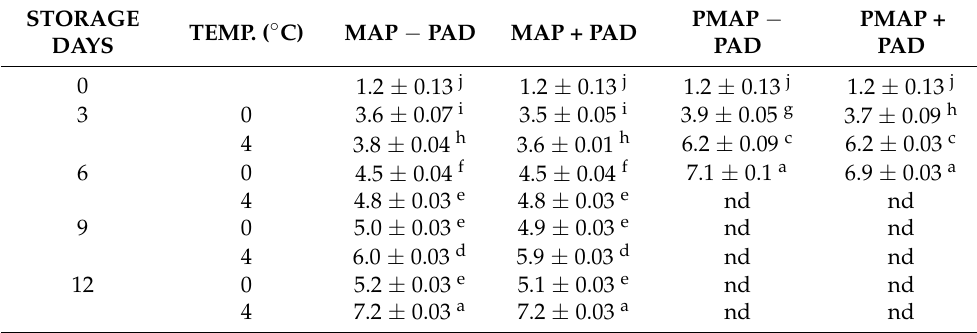
Table 1. Effects of packaging with/without absorbent pad, temperature (0 ◦ C and 4 ◦ C) and storage time (d) on bacterial growth of Cape hake